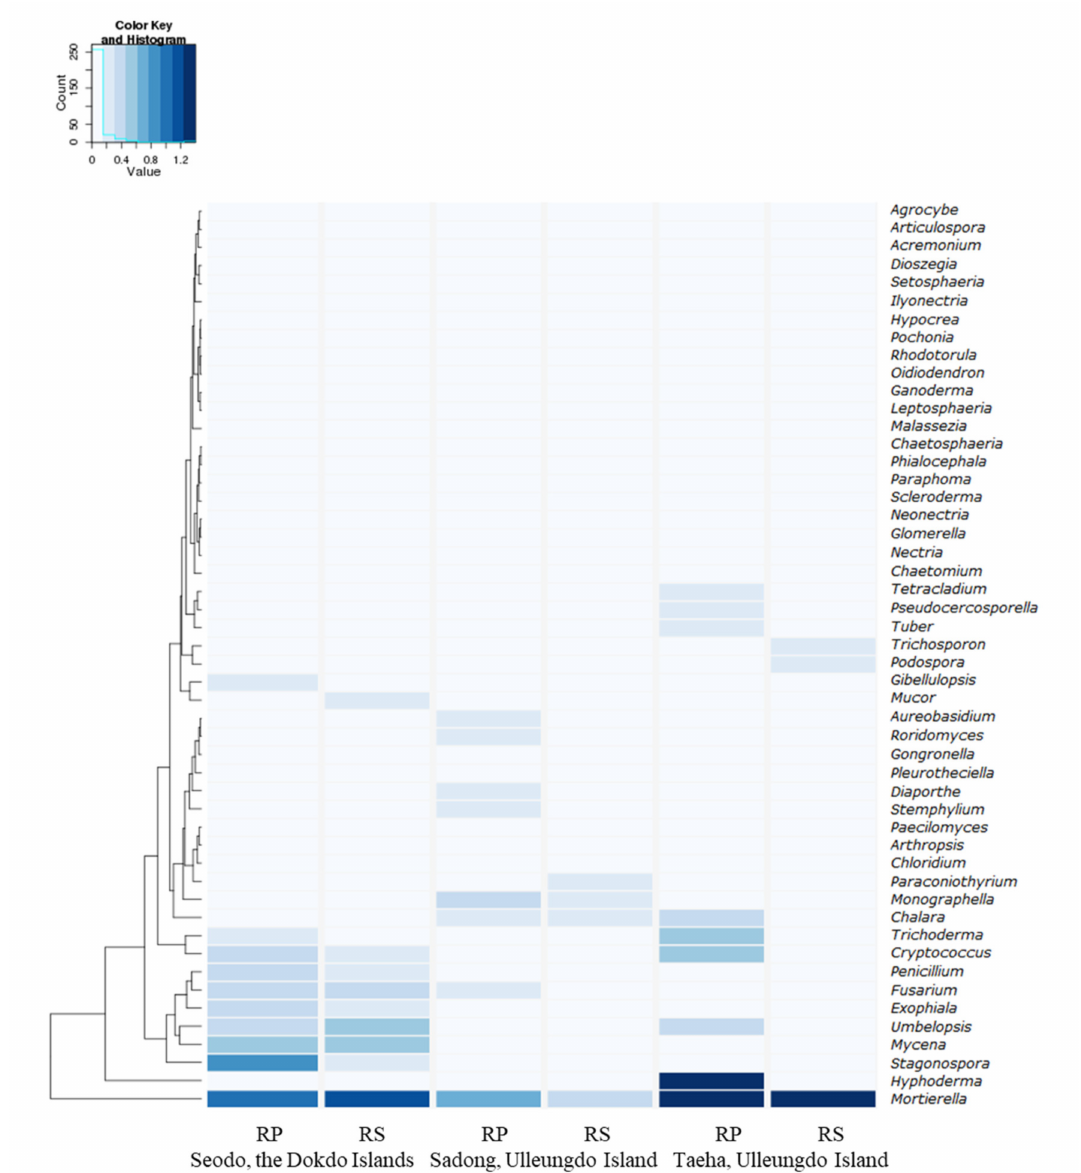
Figure 5. Heatmap of the 50 major fungal genera, including Mortierella species, distributed around host plants in each geographically segregated environment with a hierarchical